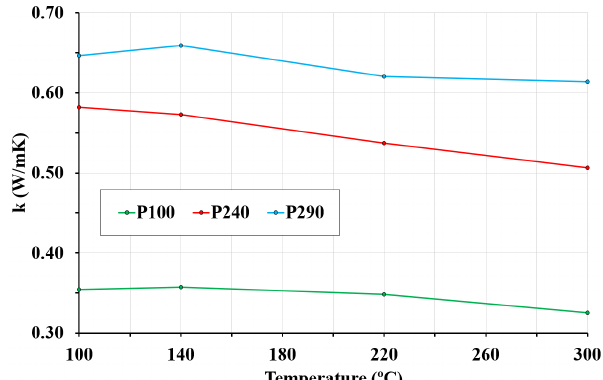
Figure 4. Thermal conductivity for LWC-1 at different pressures (100, 240, and 290 N/cm 2 ).